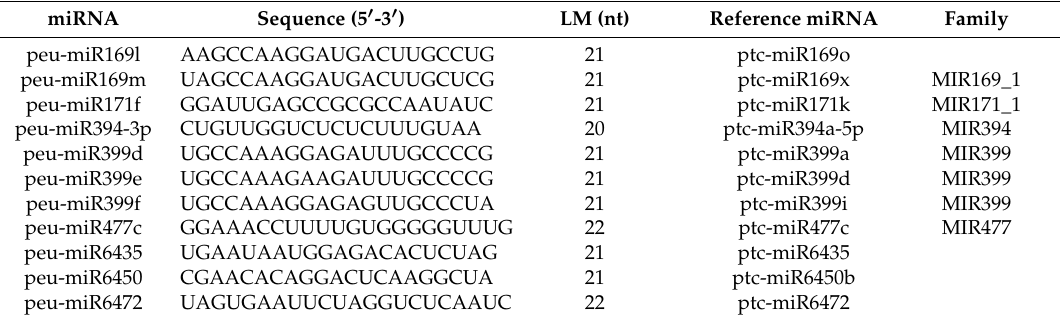
Table 2. Known miRNA specially detected in the stems and roots of P. euphratica (not in leaves). miRNA Sequence (5 (cid:48) -3 (cid:48) ) LM (nt)